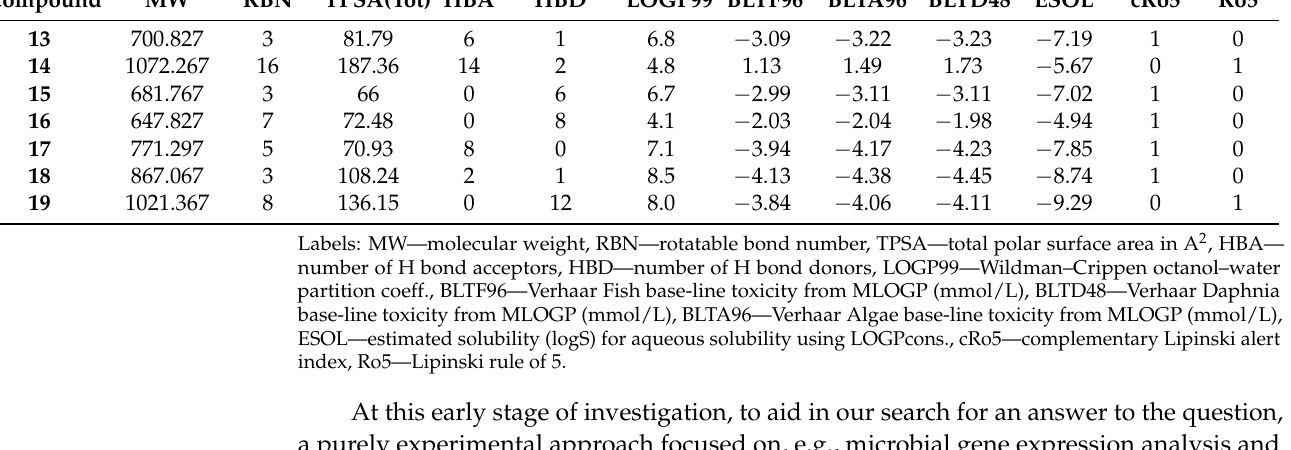
Figure 4. Structures of previously published active fac -[Re(CO) 3 ] + complexes. Complex 13 [32] ;